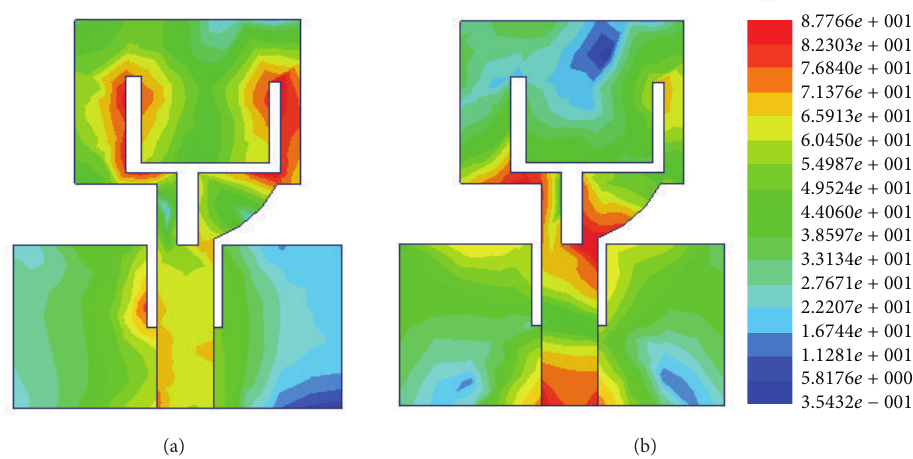
Figure 5: Current distribution of the proposed notched antenna. (a) 6GHz; (b) 9 GHz.